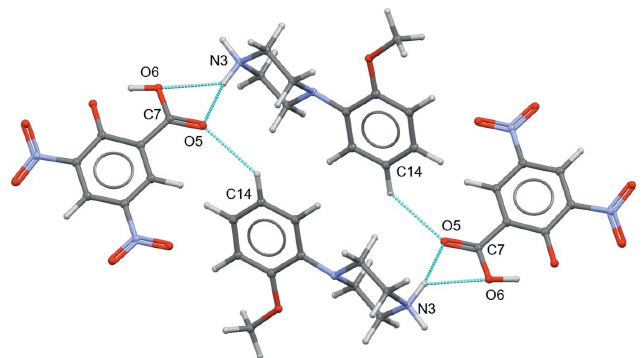
Figure 3 The bifurcated intermolecular N3—H3 A (cid:2)(cid:2)(cid:2) (O5,O6) hydrogen bond and the C14—H14 (cid:2)(cid:2)(cid:2) O5 interaction linking the 2MeOPP +1 cation and (DNSA) (cid:3) 1 anion into a centrosymmetric tetramer architecture with an R 2 (20) motif. 2